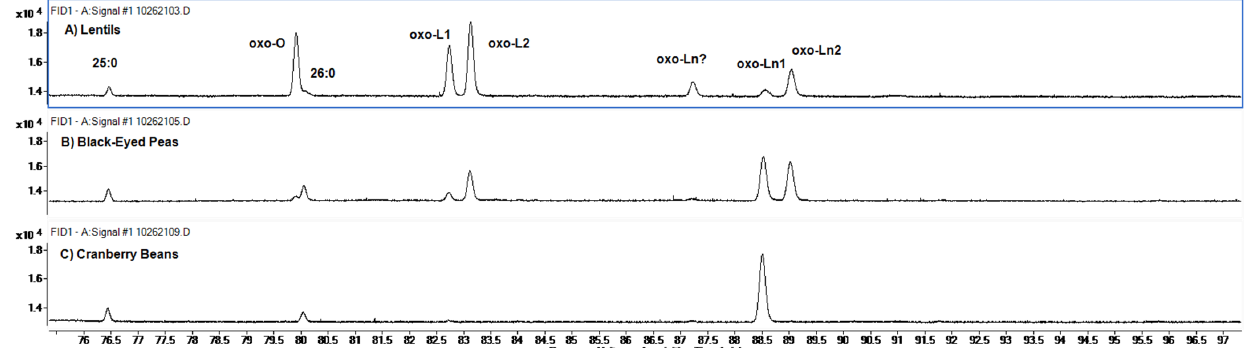
Figure 5. Partial FID chromatograms showing peaks for oxygenated FAME observed for ( A ) lentils, ( B ) black-eyed peas, and ( C ) cranberry beans. The peak labeled oxo-O corresponds to an oxygenated 18:1 FAME. The peaks labeled oxo-L1 and oxo-L2 correspond to oxygenated 18:2 FAME. The peaks labeled oxo-Ln1 and oxo-Ln2 correspond to oxygenated 18:3 FAME. The peak labeled oxo-Ln? could